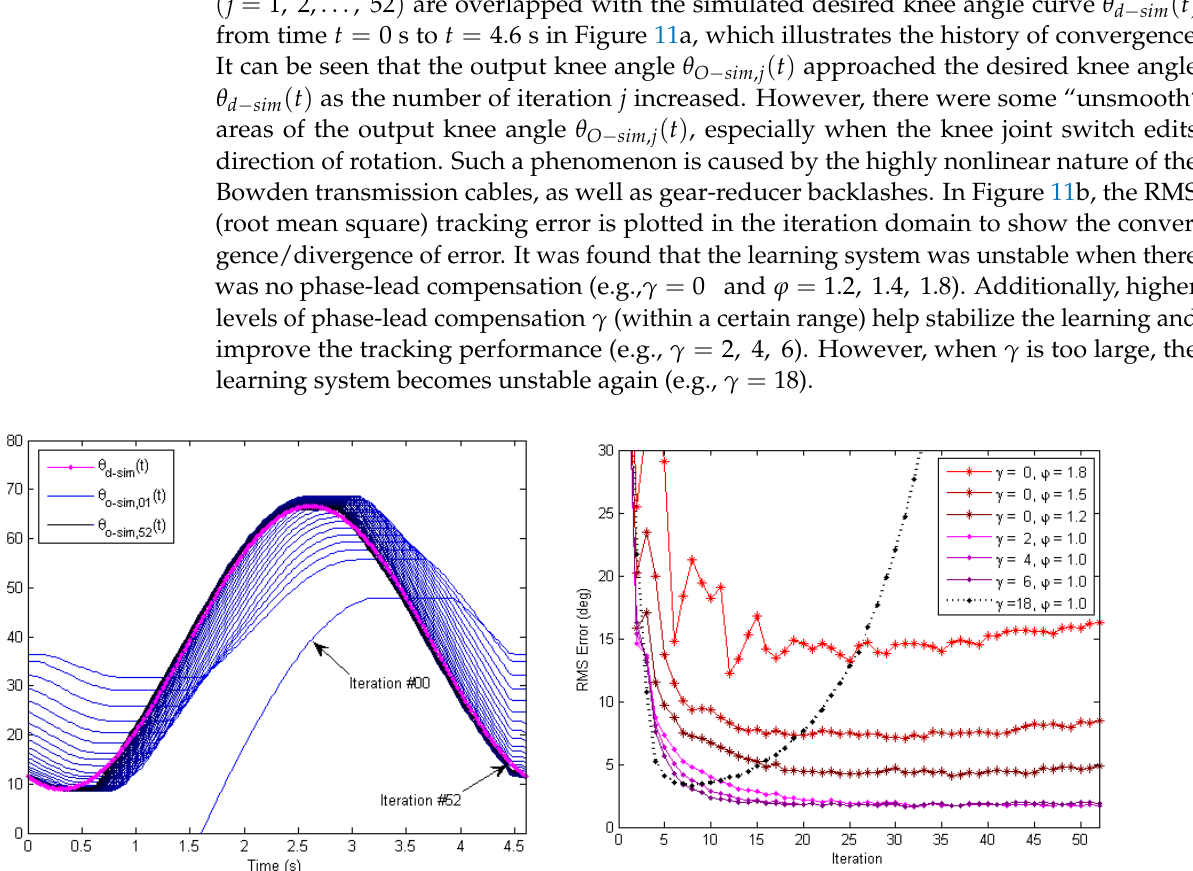
Figure 12. Experimental setup to test the learning-based repetitive controller for the soft knee ex- oskeleton with nonlinear friction and backlash of the Bowden transmission cables.